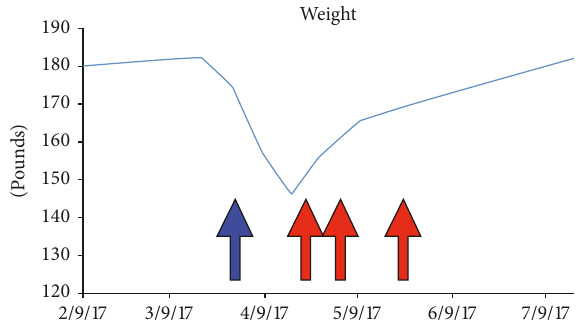
Figure 3: Charted weights. Significant weight loss seen on pre- sentation (blue arrow). Red arrows: indication dates of infliximab administration with the corresponding weight